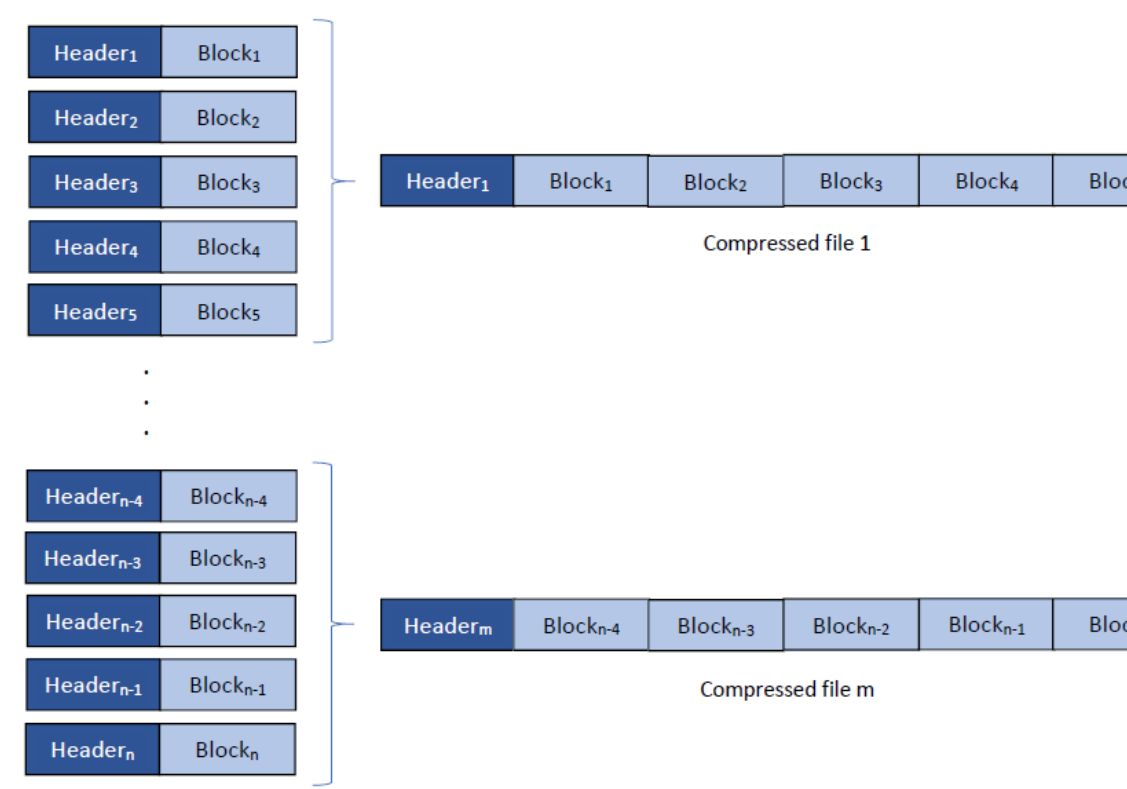
Figure 6. Strategy of packing various compressed frames into a single